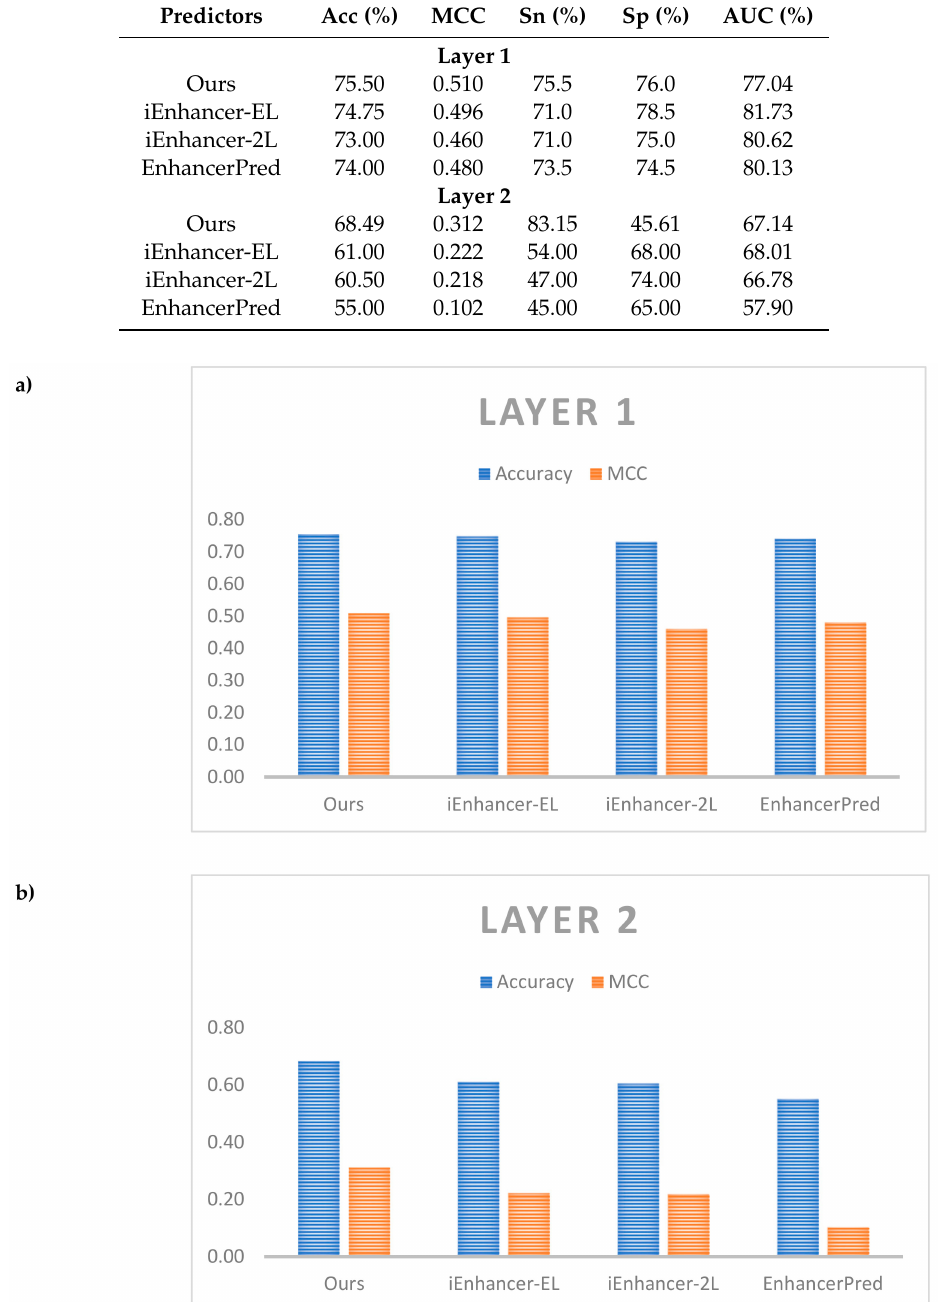
Table 8. Independent test results between our proposed method and the other state-of-the-art predictors.